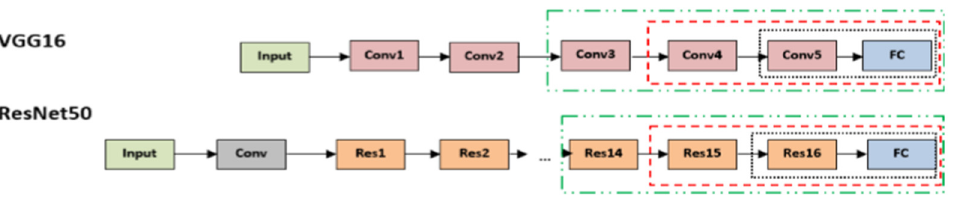
Figure 3. The architecture of VGG16 and